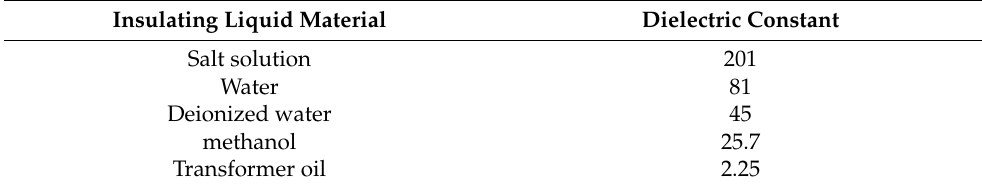
Table 4. Dielectric constant of different